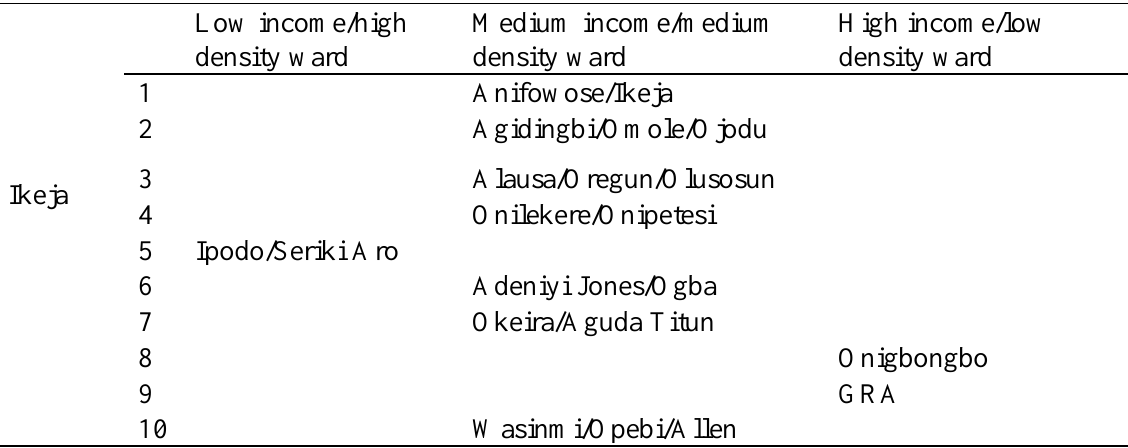
Table 1. Wards within Ikeja Local